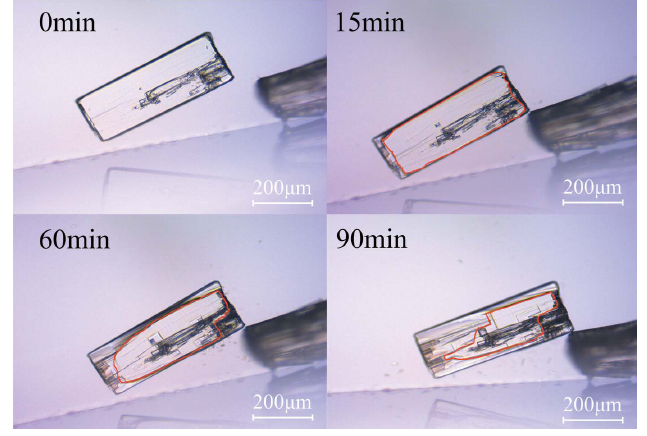
Figure 10 Time-resolved optical micrographs of the Rac -DMY–THE cocrystal in a saturated R , R -DMY–THE solution showing the selective dissolution of crystal fragments.